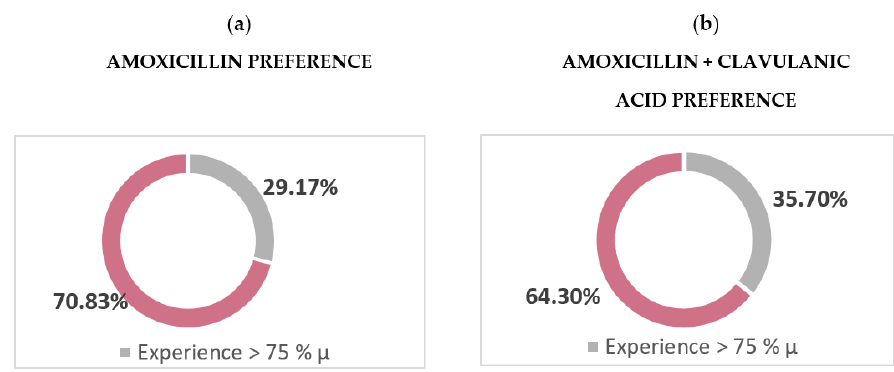
Figure 2. Percentages of antibiotic prescriptions according to experience as general dentists, where p > 0.05.